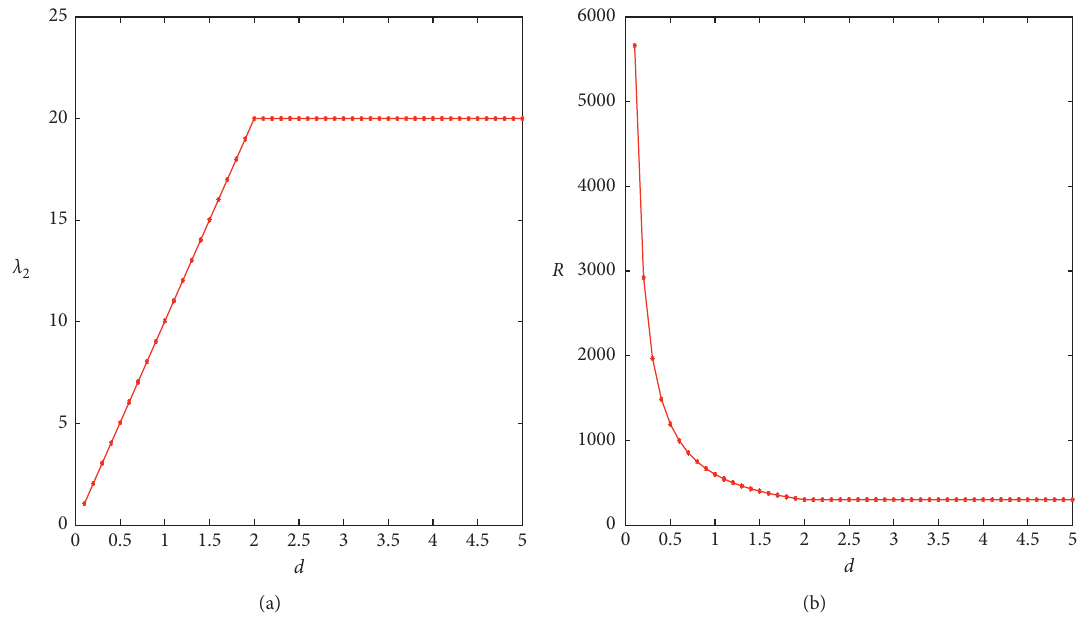
Figure 12: The synchronizability of multilayer star-ring networks vs . varying the interlayer coupling strength d ( N � 300, M � 10, a � 20, and d 0 � 2). (a) λ 2 with respect to varying d . (b) R with respect to varying d .